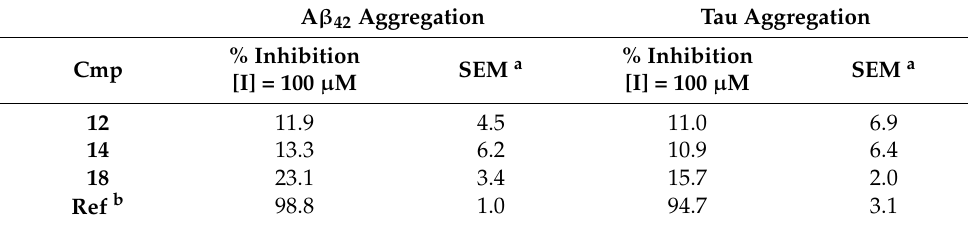
Table 6. Inhibition of A β 42 aggregation and tau aggregation by tested compounds.